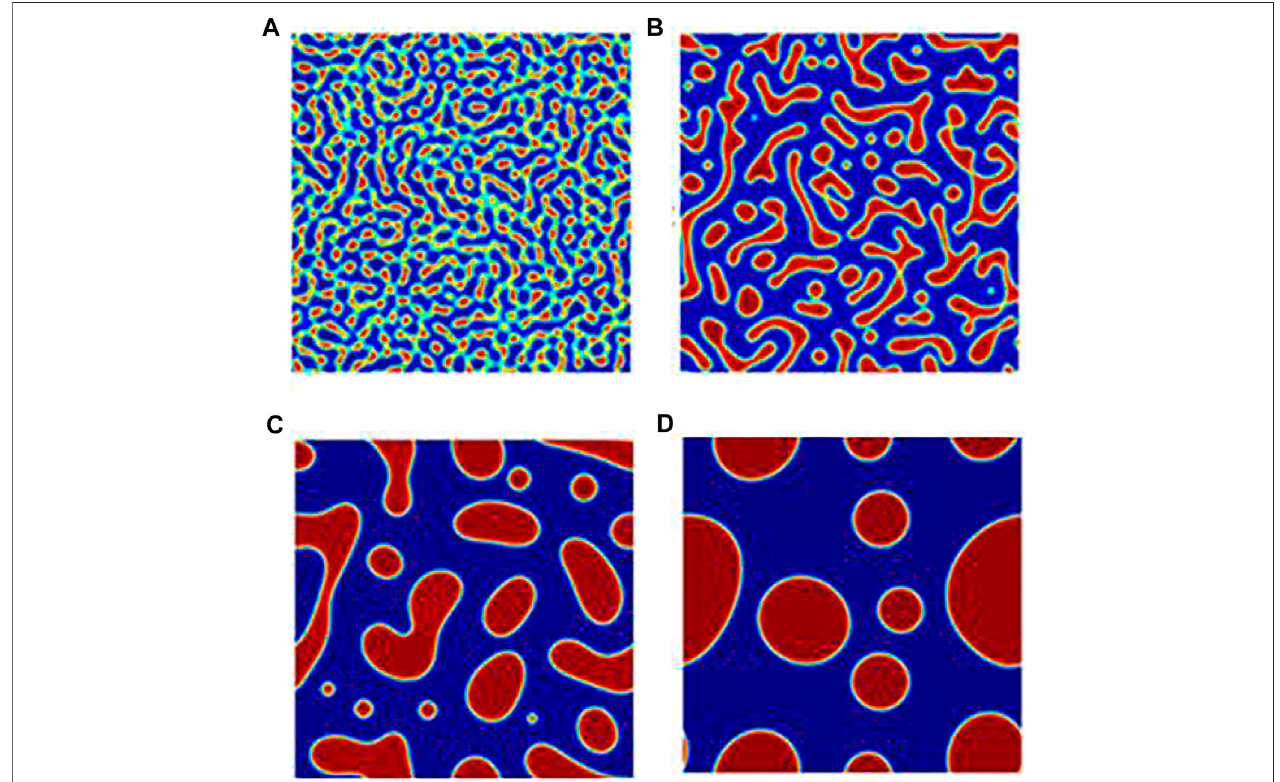
FIGURE 3 | Density fi elds under isothermal conditions for phase separation procedures with ρ p (cid:2) 1.2 and τ p (cid:2) 1 using the interactive strengths with G (cid:2) − 100 at four times: (A) 100 ts, (B) 200 ts, (C) 300 ts, and (D) 1800 ts.